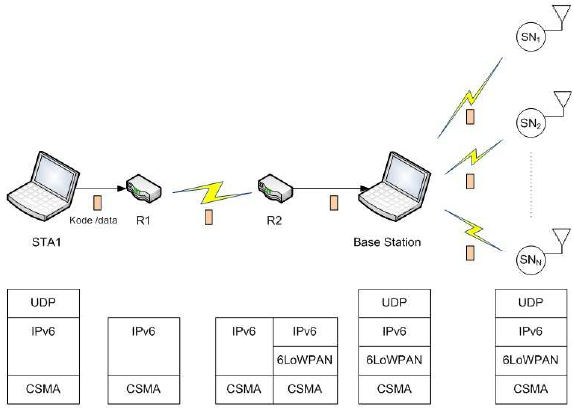
Figure 9. Network topology for the proposed scheme experiment using